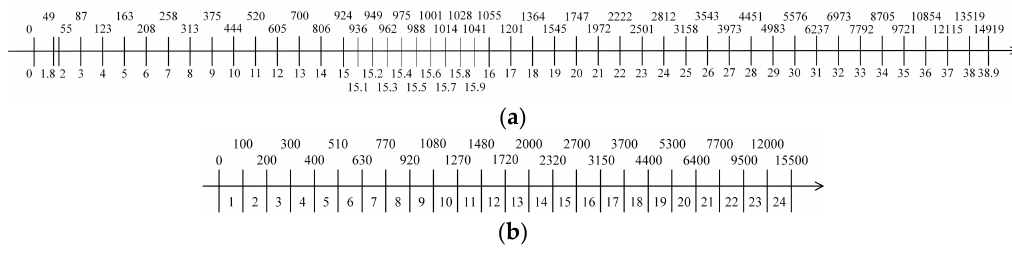
Figure 1. Frequency distribution characteristics of equivalent rectangular bandwidth ERB and critical bands. ( a ) Central frequencies of ERB bands; ( b ) Boundary frequencies of critical bands.